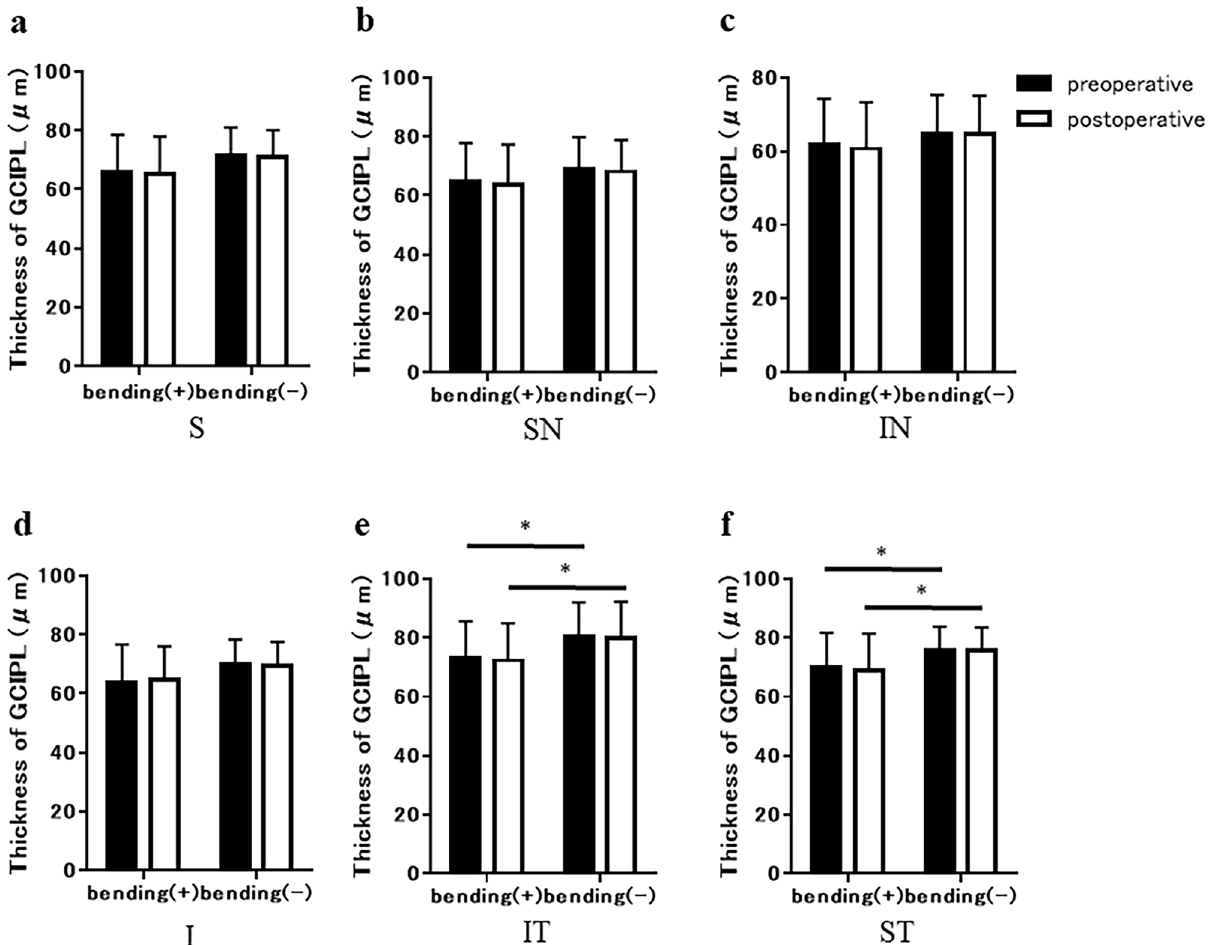
Figure 3. Comparison of ganglion cell layer (GCL) + inner plexiform layer (IPL) thickness between preoperatively (black bar) and postoperatively (white bar) in eyes with and without optic nerve bending. Graphs showed the superior (S) ( a ), superior nasal (SN) ( b ), inferior nasal (IN) ( c ), inferior (I) ( d ), inferior temporal (IT) ( e ), and superior temporal (ST) ( f ) sectors of the macular, respectively. There was no significant difference in pre- and postoperative GCL + IPL thickness in all sectors (all p > 0.05). Both preoperatively and postoperatively, GCL + IPL thickness in the inferior temporal (IT) and superior temporal (ST) sectors